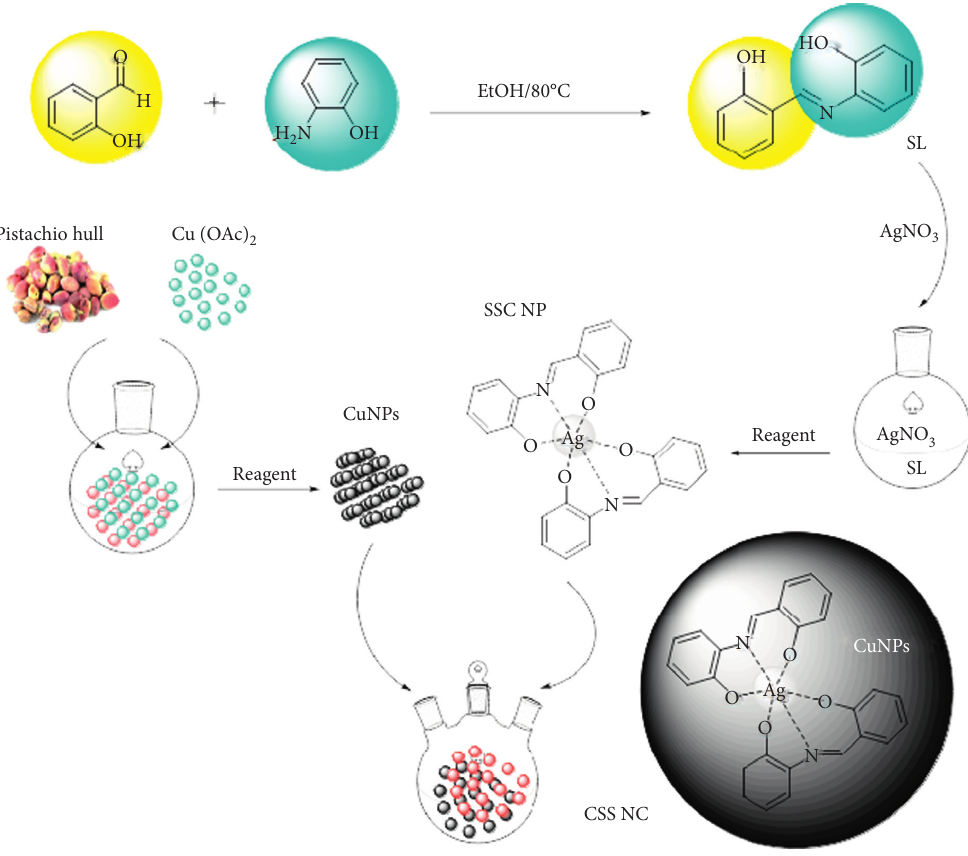
Scheme 1: The synthesis procedure of CSS NC.